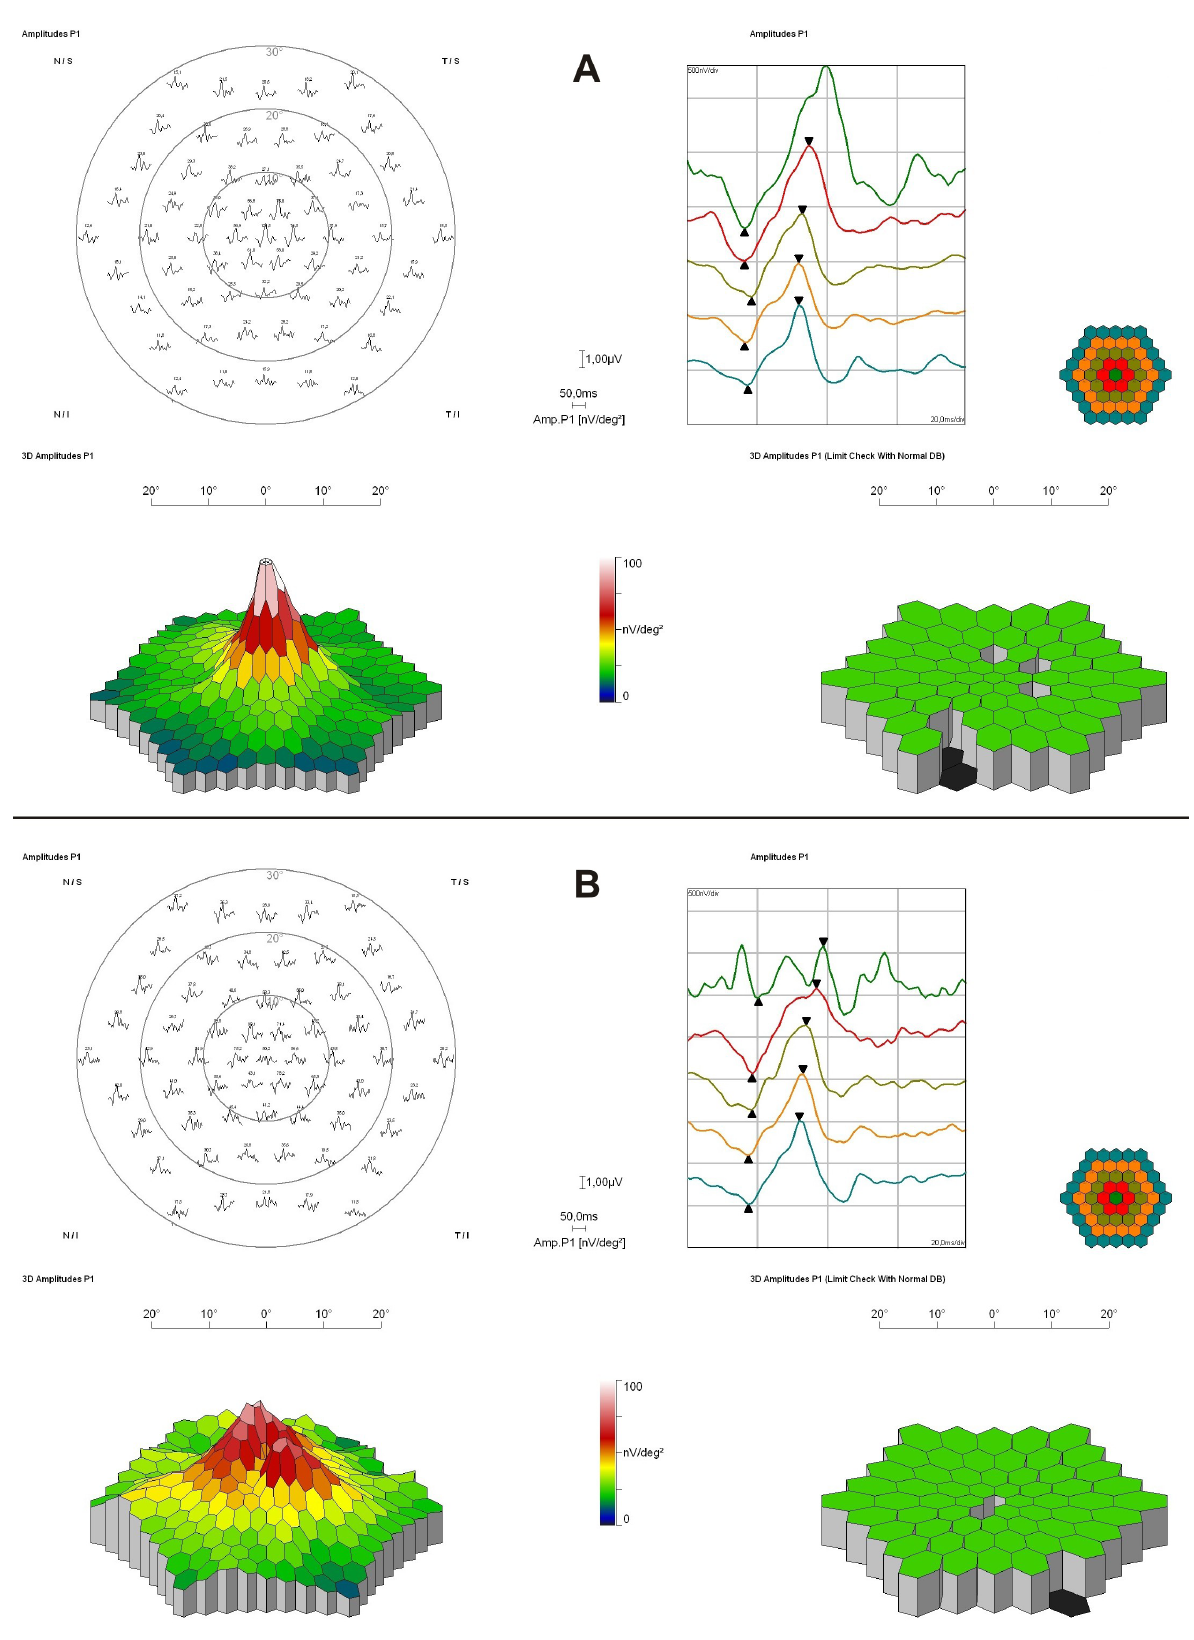
Fig. 3A-B. Patient 6. 3A. Multifocal ERG (mfERG) of the right eye, normal local and average responses. 3B. MfERG of the left eye before treatment, foveal area showed decreased responses (foveal activity was 40% of the laboratory standard), the others responses were